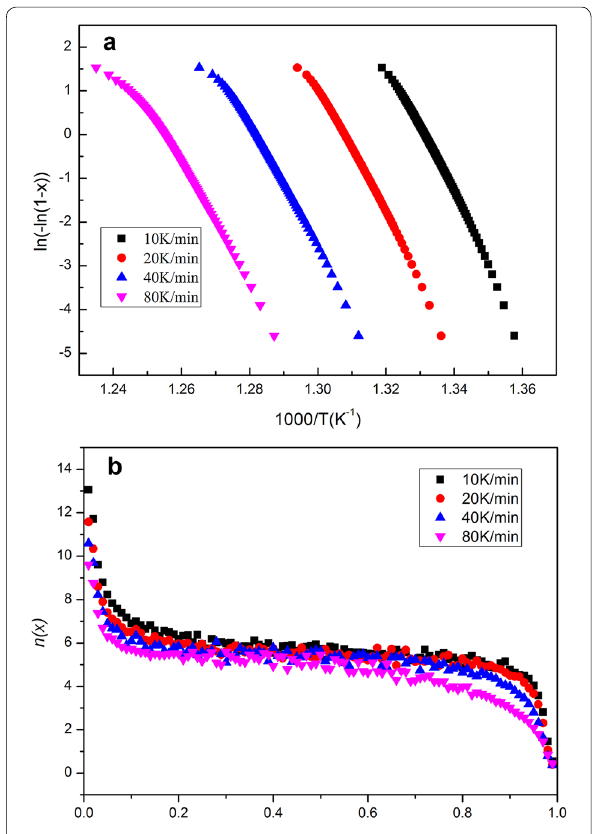
Figure 7 a ln[ ln(1 x )] vs. 1000/ T plots measured under different − − heating rates; b The plots of local Avrami exponent n ( x ) as a function of crystallized fraction x under heating rates of 10, 20, 40, 80